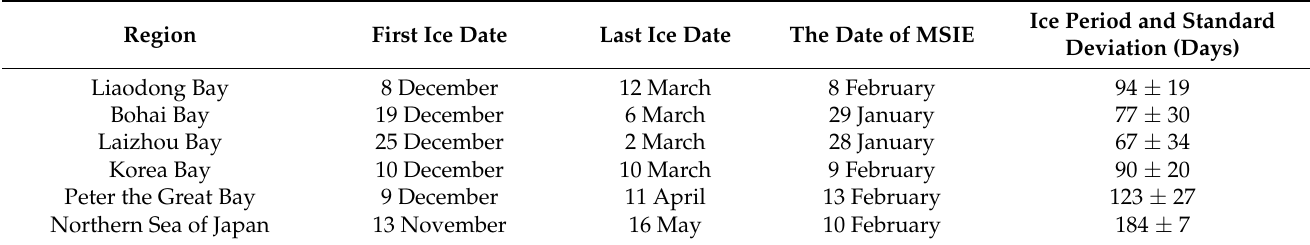
Table 1. The statistics for the first ice date, last ice date, the date of the MSIE and the ice period in the different regions of the marginal seas of East Asia from 2005 to 2021.